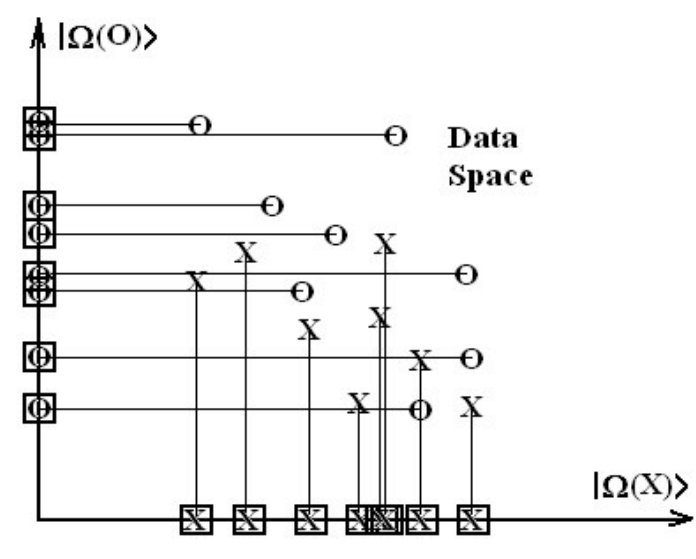
{ } O,X into orthogonal basis { } )O(,)X( WW